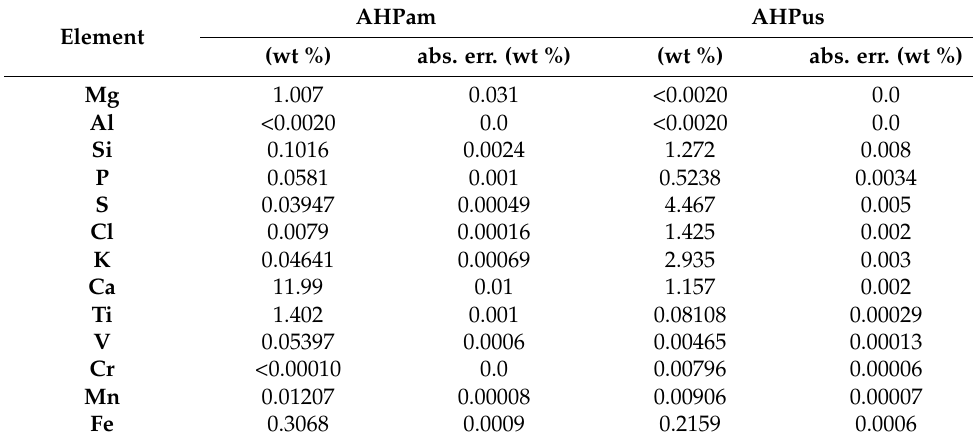
Table 4. Semi-quantitative elemental composition of AHPam and AHPus, measured by X-ray fluorescence (XRF) (abs. err. = absolute error).